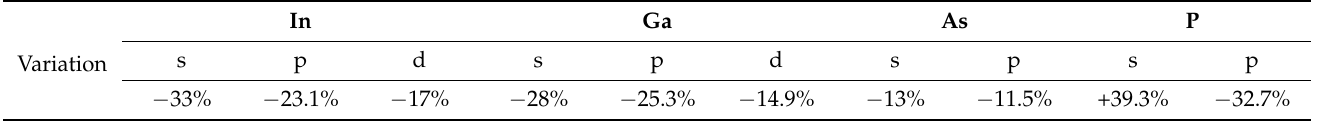
Table 1. Variation of integral partial DOS of the surface relative to the bulk.